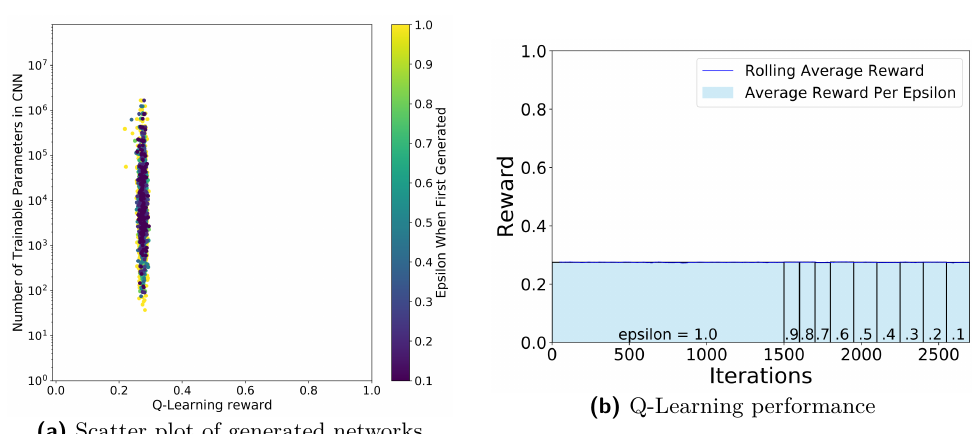
Figure 16: An overview of both the number of trainable parameters, reward, ε , and Q-Learning performance when R = a .